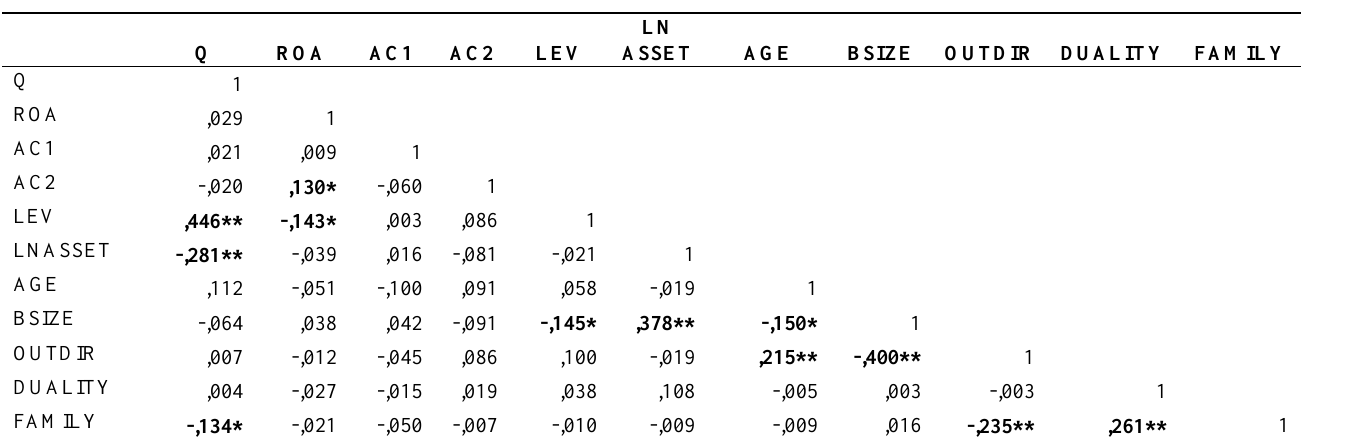
Table 2: Correlation